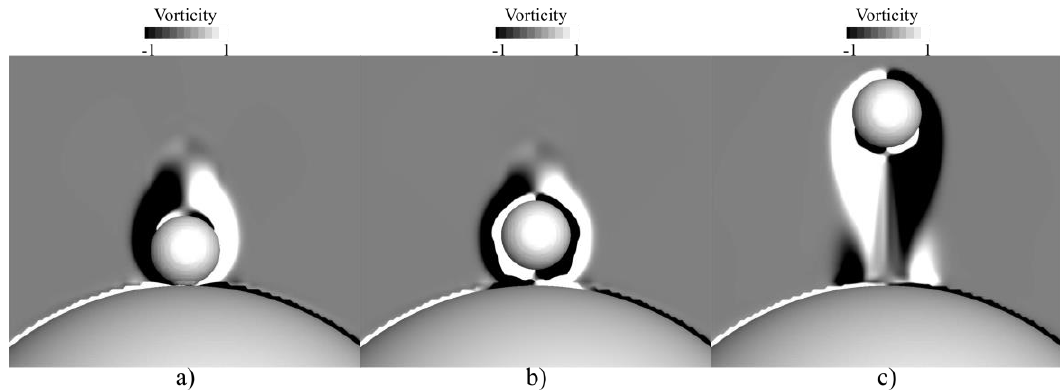
Figure 13. Vorticity distributions when a particle collides with a curved wall. ( a ) t * = 0.0, ( b ) t * = 0.1, ( c ) t * = 1.0.